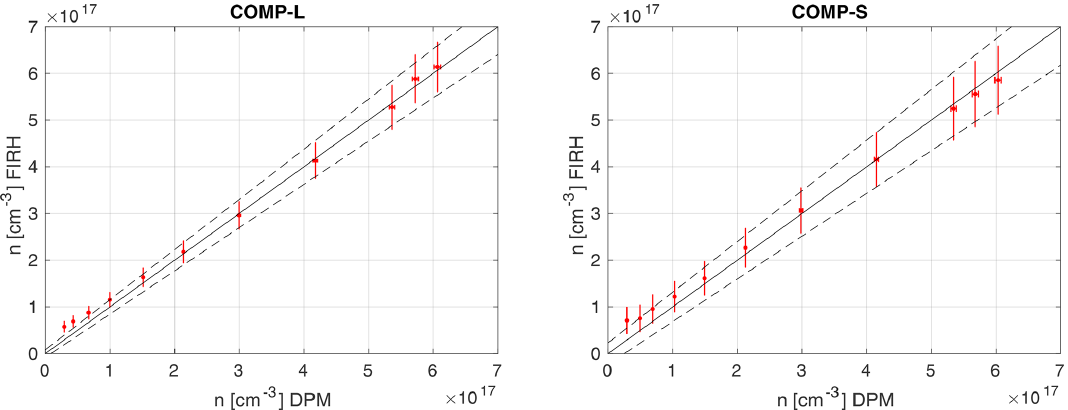
Figure 7. Comparison of FIRH with DPM (MBW973). Error bars represent the estimated errors, the solid black line is the 1 : 1 ratio and dashed lines denote the error range expected for FIRH (see text for